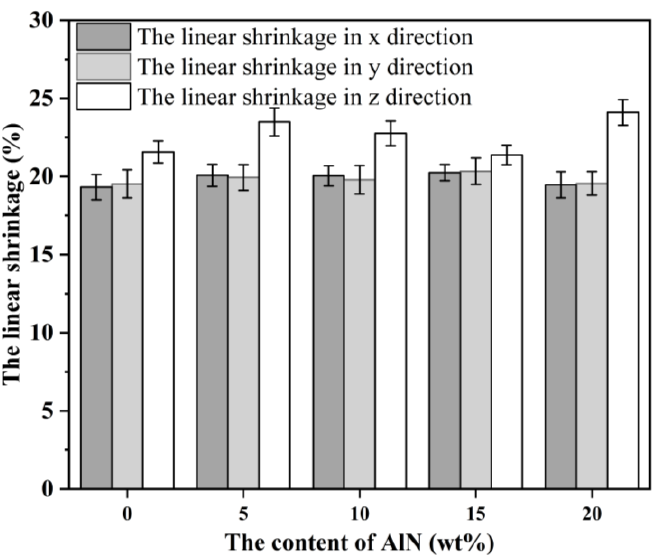
Figure 5. Normalized XRD patterns of Al 2 O 3 -AlN composites at different temperatures: ( a ) 1650 °C , ( b ) 1700 °C .